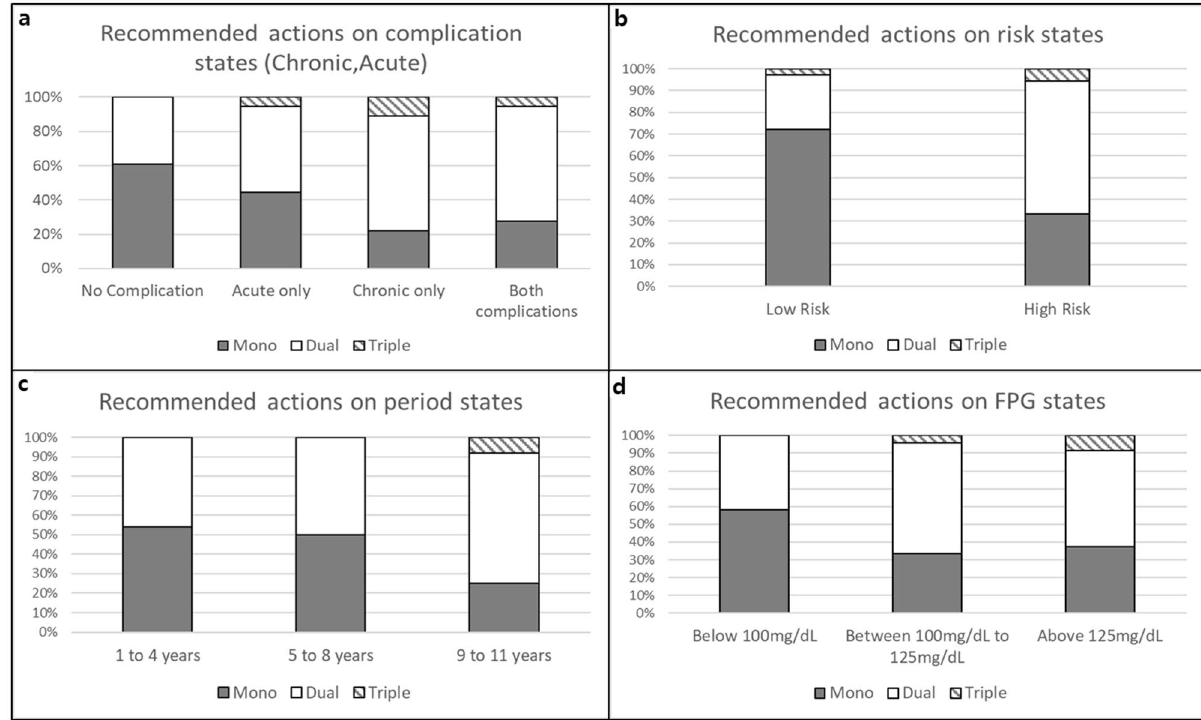
Figure 4. MDP recommendation actions on each state for female patients. This figure shows the recommended treatment actions according to each component of the states for female patients. ( a ) Is the recommended actions on complication states. ( b ) Is the recommended actions on risk states. ( c ) Is the recommended actions on period states and ( d ) is the recommended actions on FPG states. Grey shaded sqaure is for mono therapy recommendations. Open square is for dual therapy recommendations. And striped square is for triple therapy